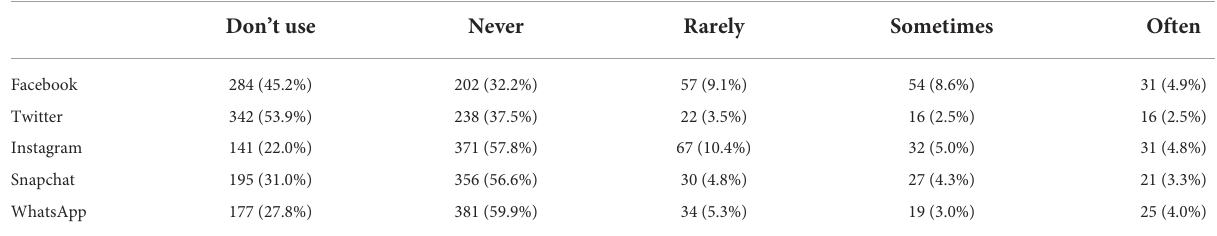
TABLE 4 Predictors of susceptibility to use betel